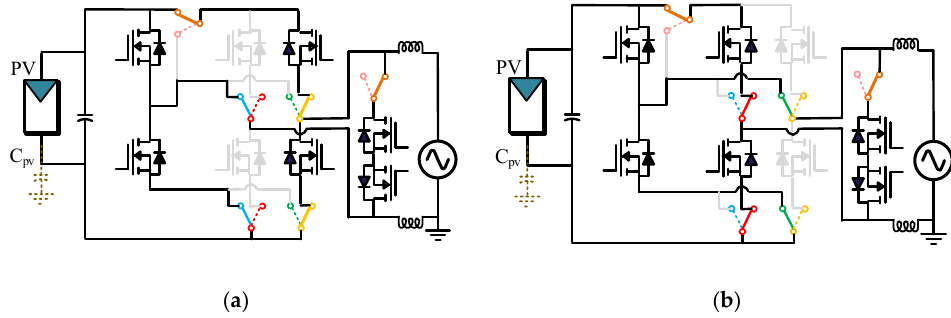
Figure 4. Configuration after a fault in one of the legs. ( a ) Configuration after a fault in Leg 1 , and ( b ) configuration after a fault in Leg 2 .